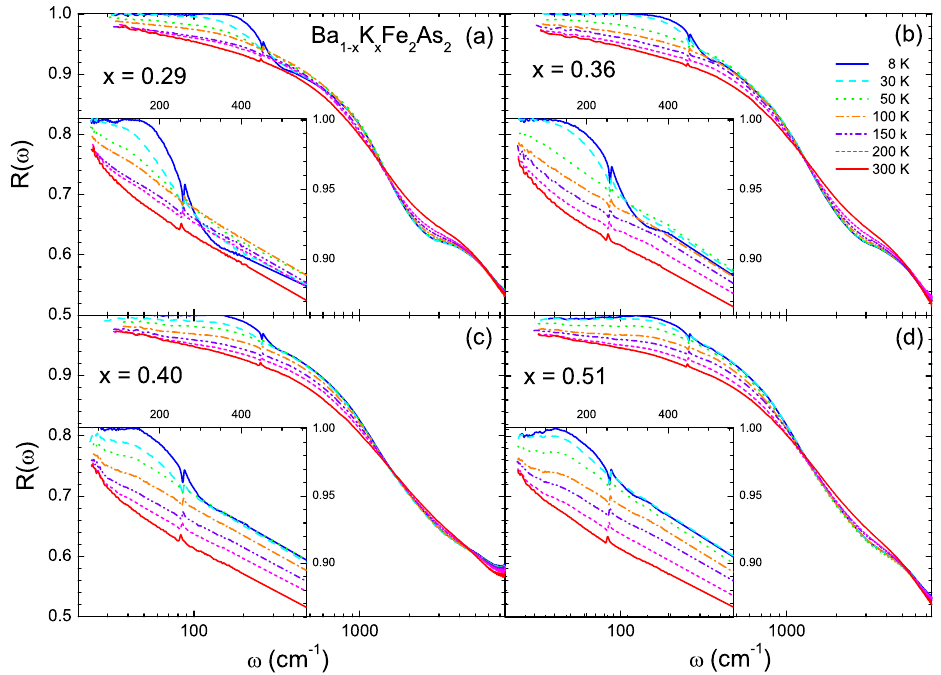
Figure 1. (Color online) Reflectance spectra of Ba 1 at various selected temperatures between 8 and 300 K; ( a ) x